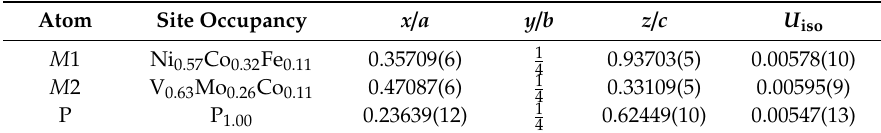
Table 3. Atoms, site occupancies, atom coordinates, and isotropic displacement parameters (Å 2 ) for grammatikopoulosite.